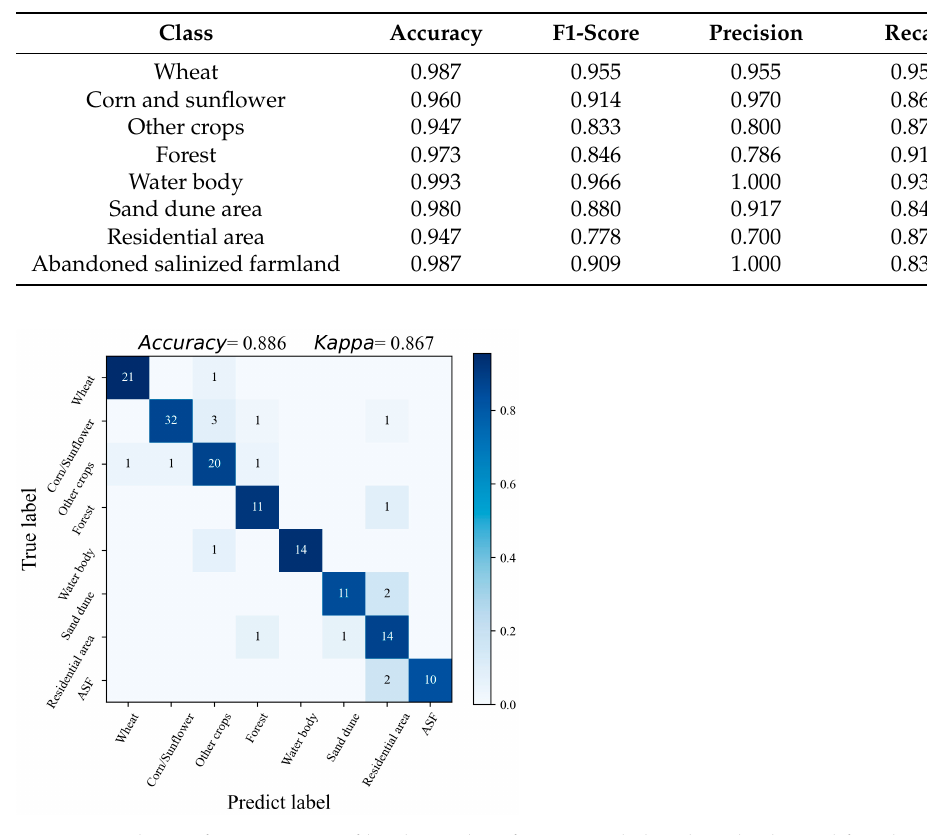
Figure 14. The confusion matrix of land-use classification and abandoned salinized farmland detec- tion results. The ASF represents the abandoned salinized farmland.